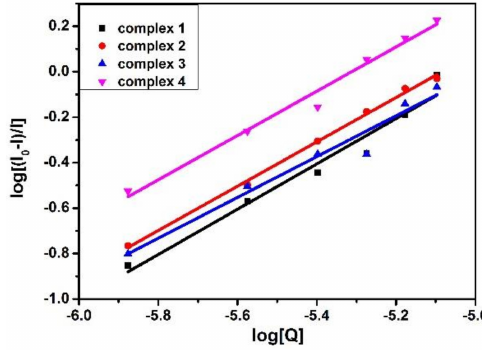
Figure 6. The plot of log[(I 0 − I)/I] versus log [Q].